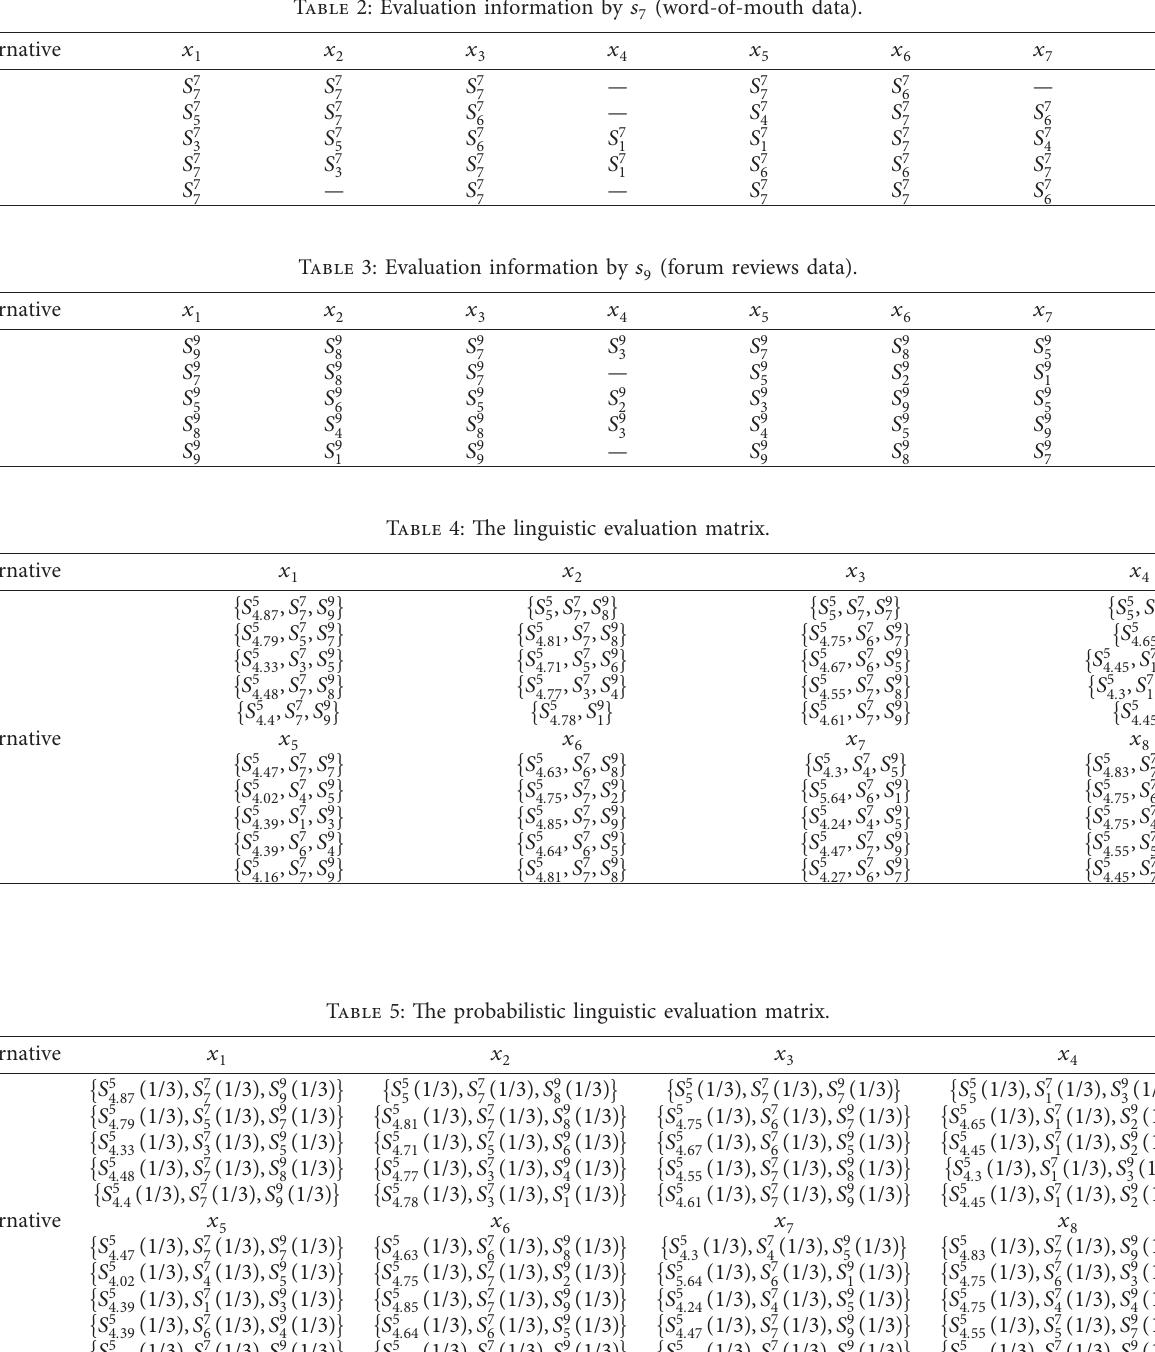
Table 2: Evaluation information by s